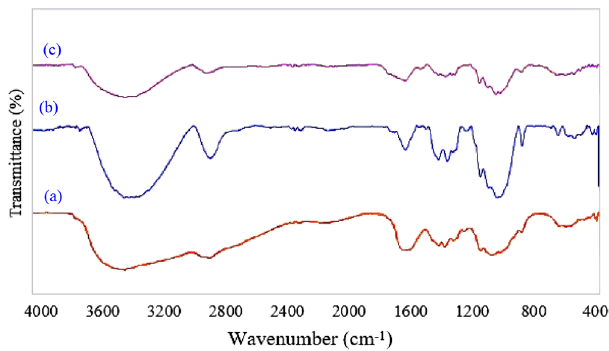
Figure 2. FTIR spectra of the chitosan ( a ), cellulose ( b ) and Cs-EDTA-Cell ( 1 , c).